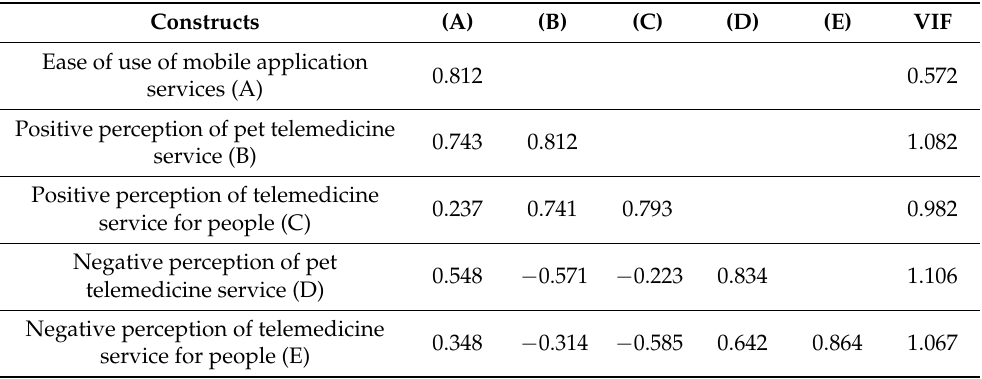
Table 6. Discriminant